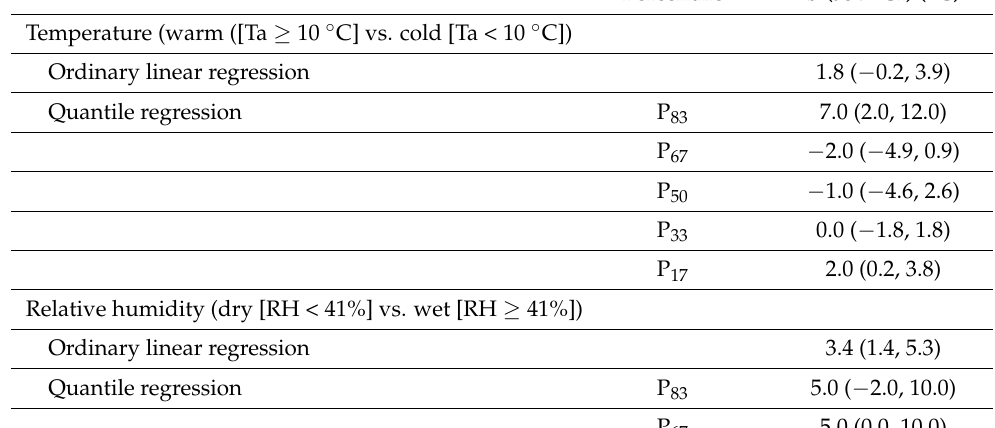
Table A3. Ordinary linear and quantile regressions of self-assessed threshold for cold on ambient temperature (Ta), relative humidity (RH), and air velocity (AV) at workplace. The crude coefficients (b) express the change in self-assessed threshold for cold ( ◦ C) in relation to the reference category.